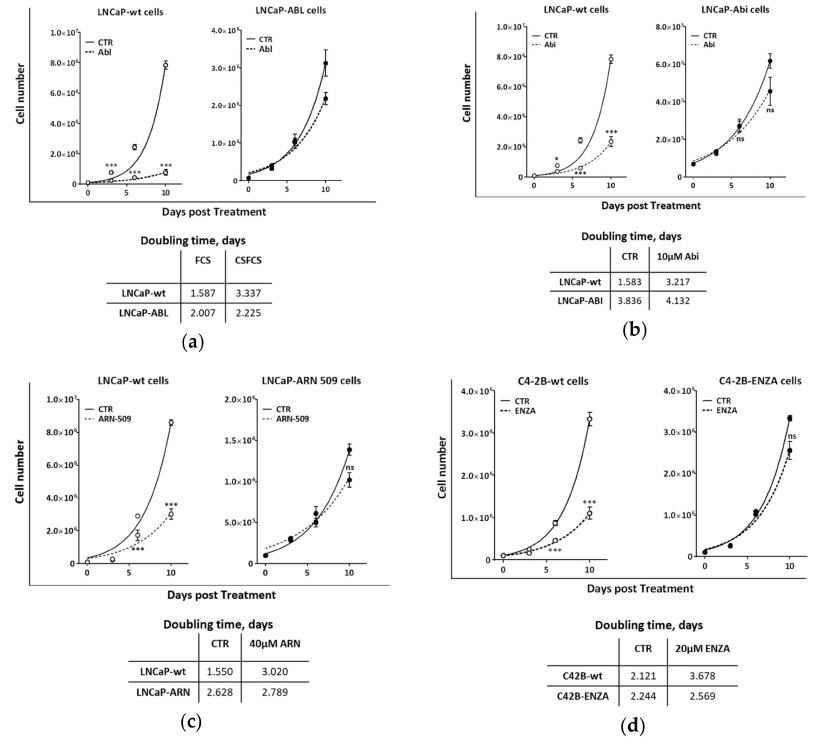
Figure 5. Resistance phenotype of ADT resistant PCa cells. Cell number was determined on days 0, 3, 6 and 10 post treatment with ( a ) hormone ablation, ( b ) 10 µ M abiraterone acetate, ( c ) 40 µ M apalutamide, or ( d ) 20 µ M enzalutamide. Cells used are LNCaP (LNCaP-wt) cells, and their resistant sublines to: hormone ablation (LNCaP-abl), abiraterone acetate (LNCaP-abi), or apalutamide (LNCaP-ARN509), as well as wildtype C4-2B (C4-2B-wt) cells, or their resistant subclone to enzalutamide (C4-2B-ENZA). Cell-doubling time was calculated for each treatment by fitting exponential growth curves using GraphPad Prism 7. Shown are means ± SEM of at least three independent experiments. Significance is indicated as * for p < 0.05, and *** for p < 0.0001, ns: not